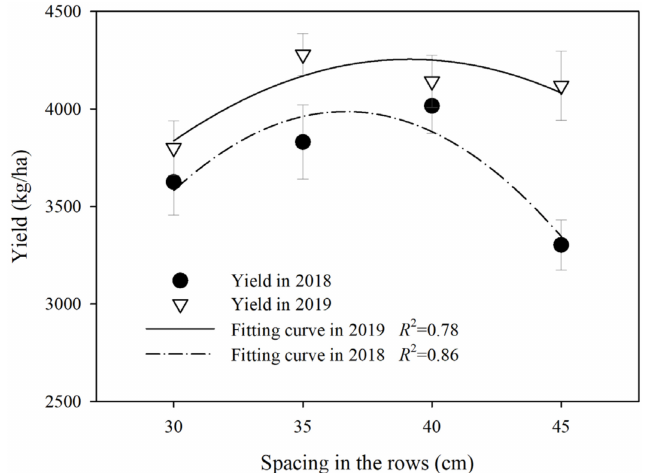
Figure 4. Sunflower yields in the two growing seasons under different treatments (different spacing in the rows). (Error bars indicate the standard